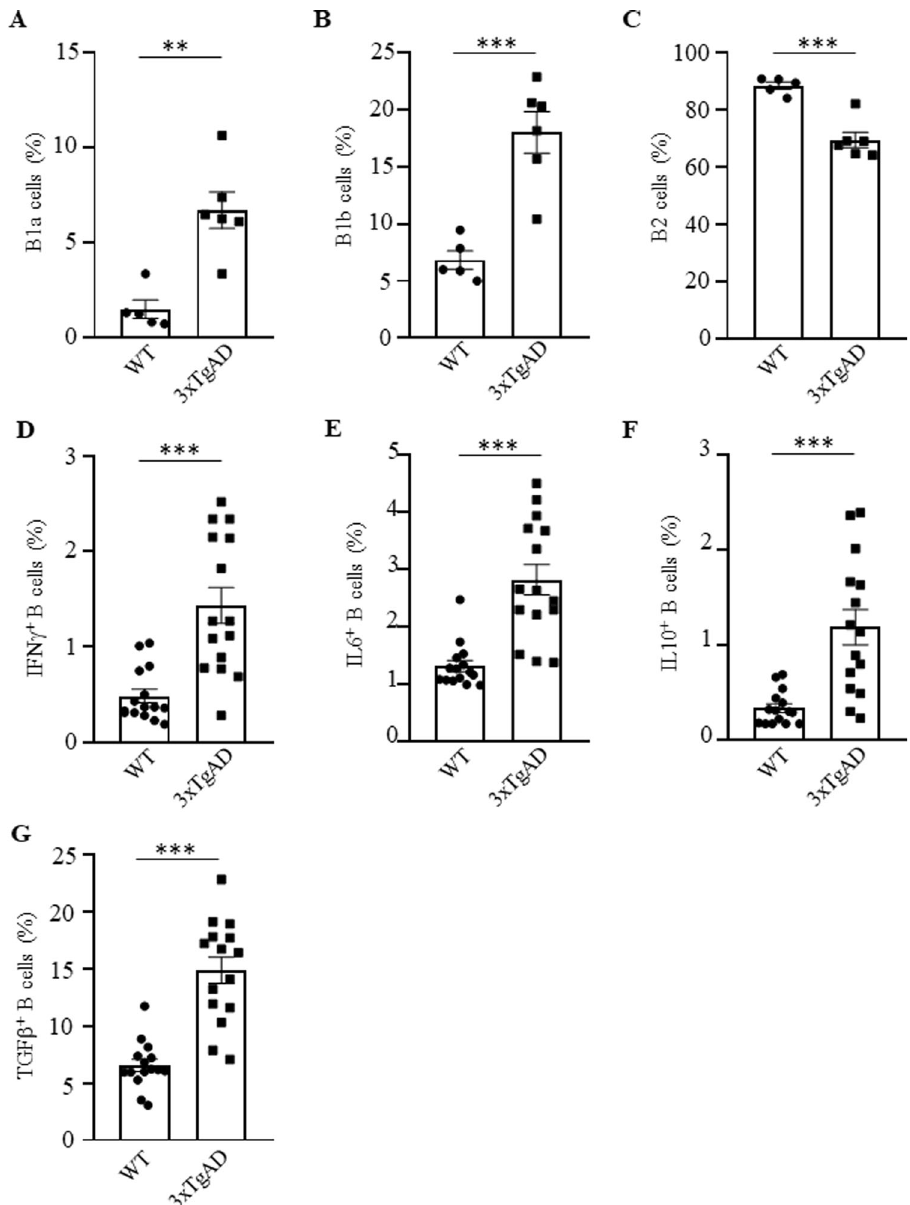
Fig. 1 Activated B cells were increased in 3×TgAD mice. Compared with congenic, age- and sex-matched WT mice, B1a (CD5 + CD11b + CD19 + , A ) and B1b cells (CD5 − CD11b + CD19 + , B ) were increased, while B2 cells (CD5 − CD11b − CD19 + , C ) were decreased in the cervical lymph nodes of 3×TgAD mice. AD also activated B cells, as they upregulated IFN γ ( D ), IL6 ( E ), IL10 ( F ), and TGF β ( G ) in the peripheral blood of mice. Frequency (%) mean ± SEM is shown; each symbol is for a single mouse, n = 5 – 6 in A – C , n = 15 in D – G . Gating strategy is shown in Supplementary Fig. 9A. ** p < 0.01; *** p < 0.001 in unpaired t cortex and hippocampus in 3×TgAD-BKO mice also revealed conducted an immuno fl uorescent analysis for A β plaques (using that the increase of soluble A β 42 and A β 40 was reversed ( n = 2 – 6, the 6E10 Ab) and ionized calcium binding adaptor 1 (Iba, a Fig. 3D and Supplementary Fig. 3E). Since both 3×TgAD and microglial cell marker) in cryopreserved brain sections of APP/ 3×TgAD-BKO mice express high levels of the APP transgene in PS1-BKO (30 weeks old), 3×TgAD-BKO (60 – 70 weeks old) and hippocampal neurons (Fig. 3E), we concluded that the bene fi t age- and sex-matched control mice. Given that in this model the of the B-cell de fi ciency was probably in reduced formation and/or early intraneuronal A β deposition in the subiculum is linked to increased clearance of A β peptides. Accordingly, large cognitive impairments 32 , and that the subiculum and hippo- campal CA1 atrophy is increased in AD patients 33 , from hereon ameboid microglial cells (>5 μ m 2 ), which indicate dysfunctional we primarily analyzed the subiculum. It showed a marked overactivation 34,35 and impaired clearance of A β plaques 36 , were upregulation of A β plaques in APP/PS1 and 3×TgAD mice (as signi fi cantly decreased in 3×TgAD-BKO mice to almost that of in compared with healthy control mice), which was reversed in WT mice ( p < 0.05, compared with 3×TgAD, n = 3 – 9, Fig. 3F and APP/PS1-BKO and 3×TgAD-BKO mice respectively ( n = 4 – 7, Supplementary Fig. 3F, G). In contrast, activated microglia Fig. 3A – C and Supplementary Fig. 3A – D). Analysis of frontal (regardless of their size) remained increased in APP/PS1 and